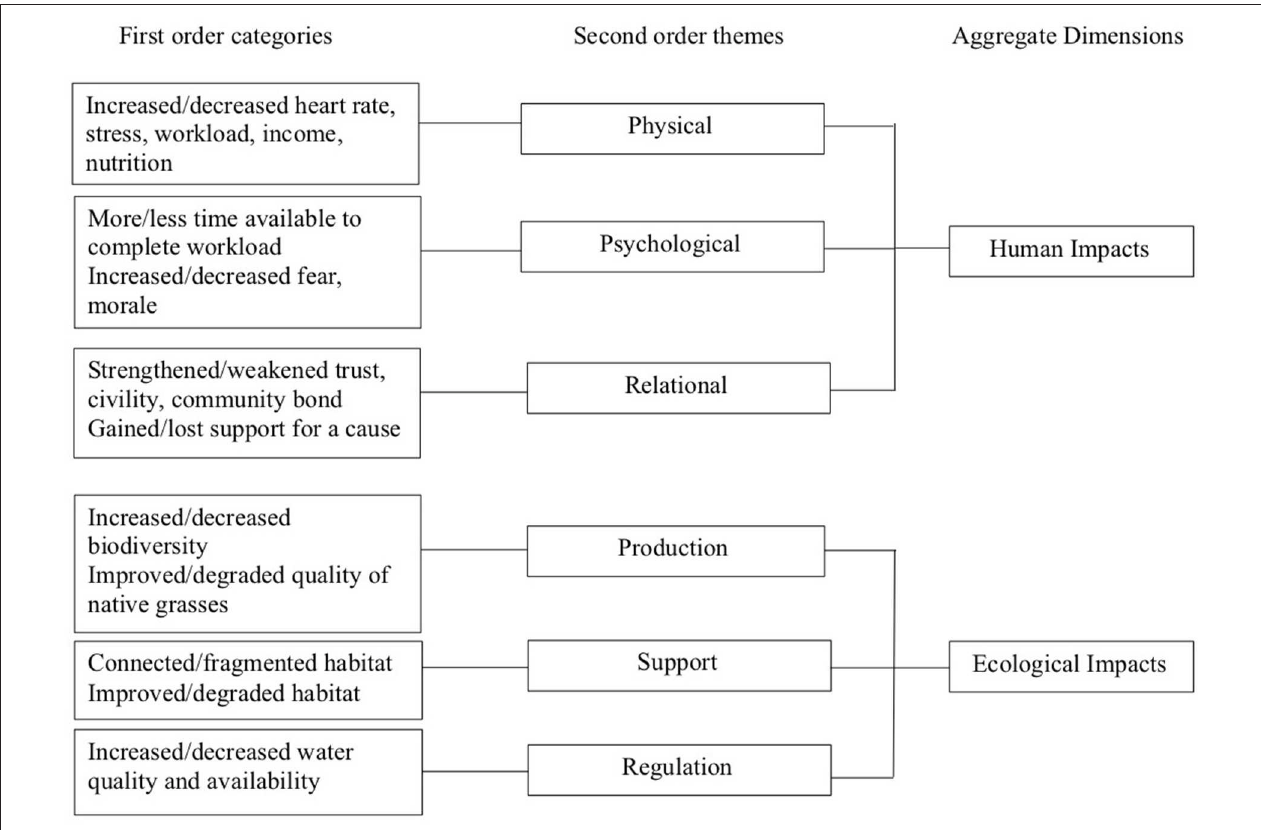
FIGURE 4 | Data Structure formed by iterative analysis to identify positive and negative change that was perceived and tangibly experienced by people and observed in a rangeland